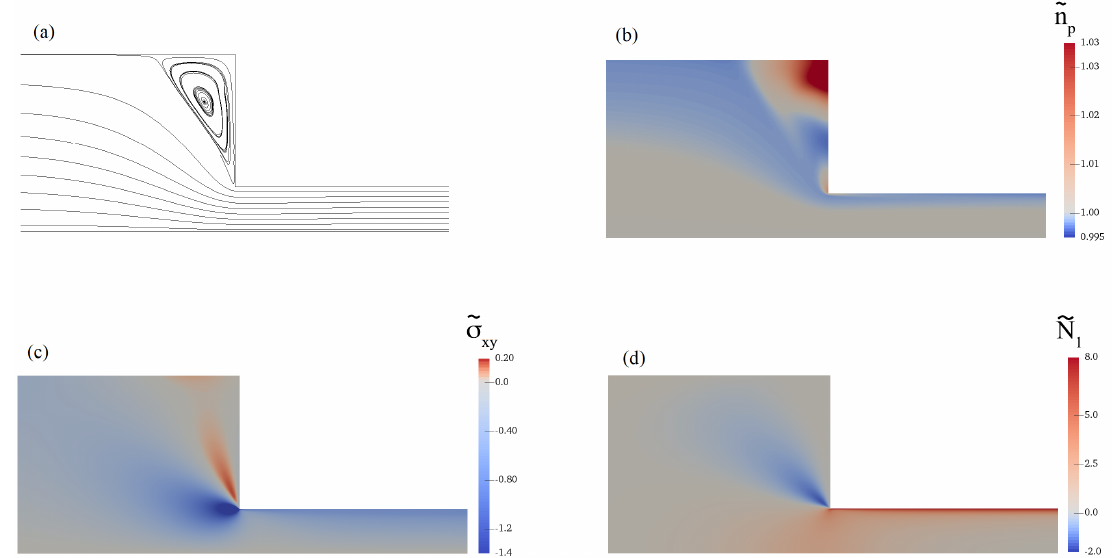
Figure 10. Contours of ( a ) stream function, ( b ) polymer number density, ( c ) shear stress, and ( d ) first normal stress difference for De = 2.0.